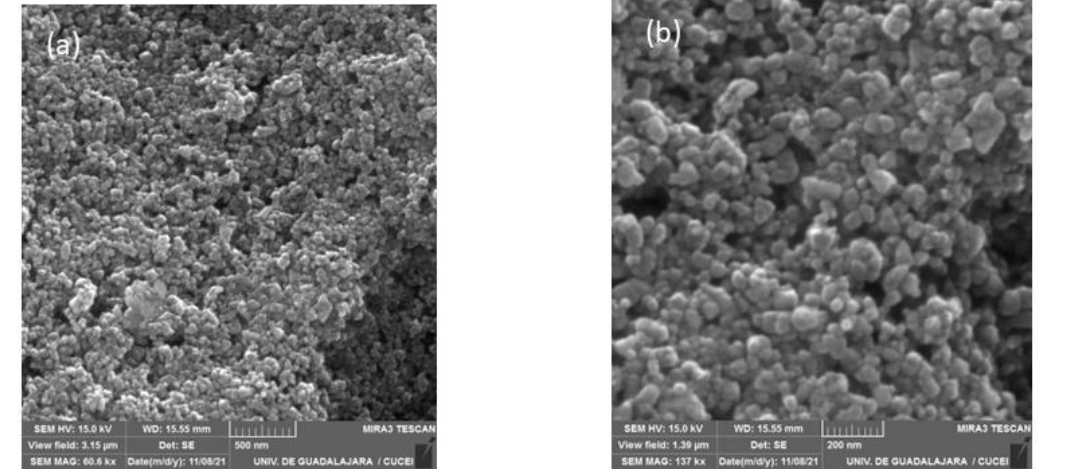
Figure 7. SEM micrographs of sample M11 at different magnifications ( a ) 500 nm and ( b ) 200 nm.